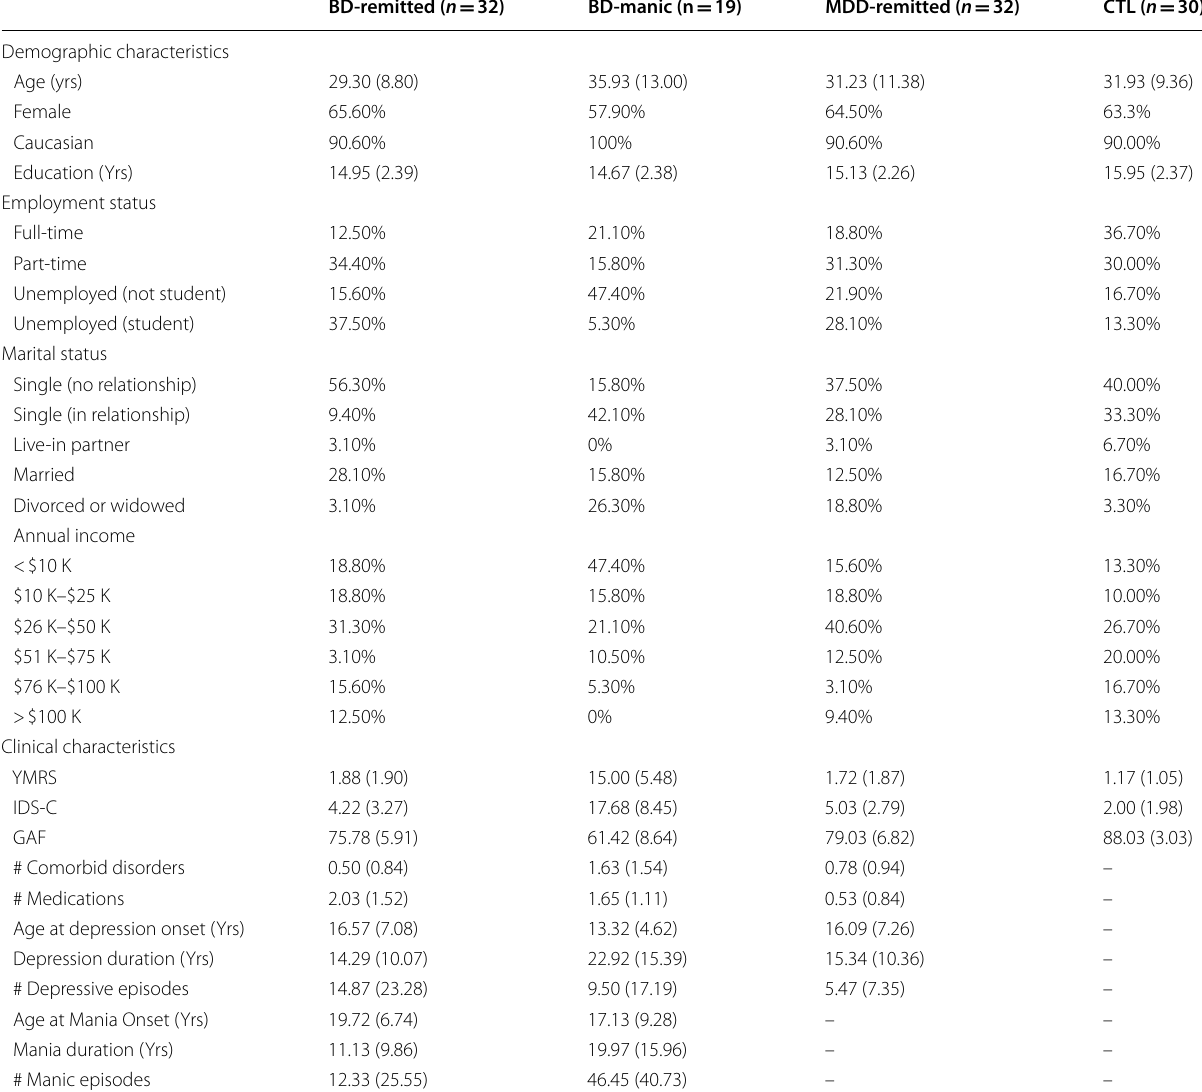
Table 1 Demographic and clinical